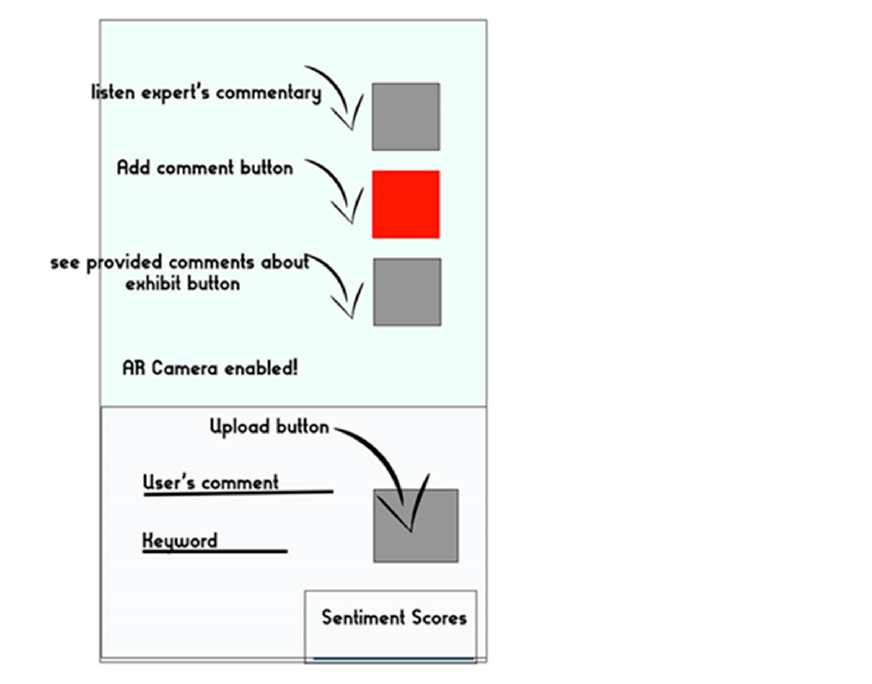
Figure 1. George Hein’s diagram classifying learning and knowledge theories ([2], p. 25).